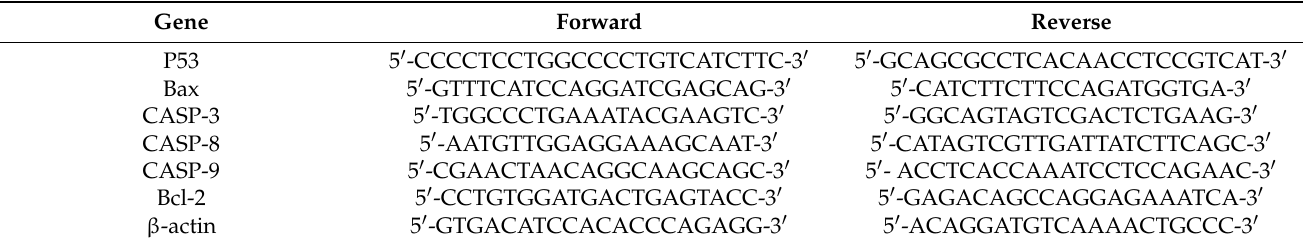
Table 1. Sequences of forward and reverse